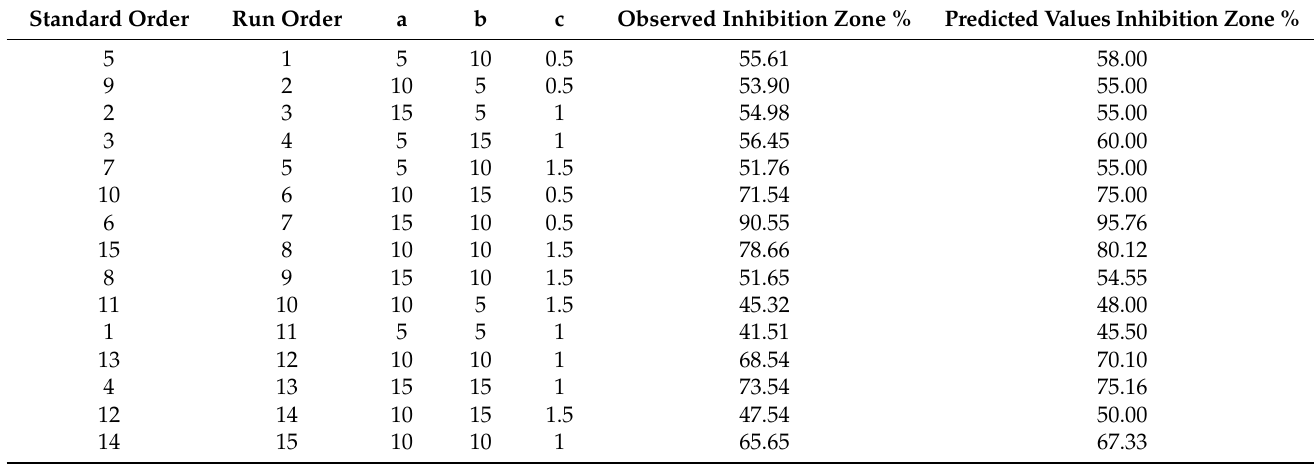
Coded values: a = semolina, b = peanut root extract, c = MgSO 4